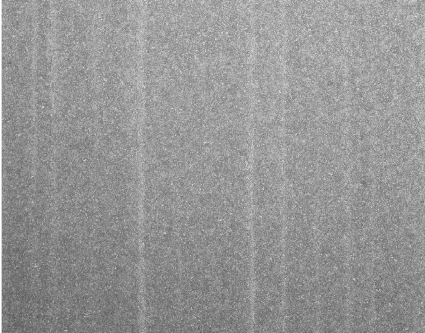
Figure 15: Micromorphology of the matrix band at the fracture